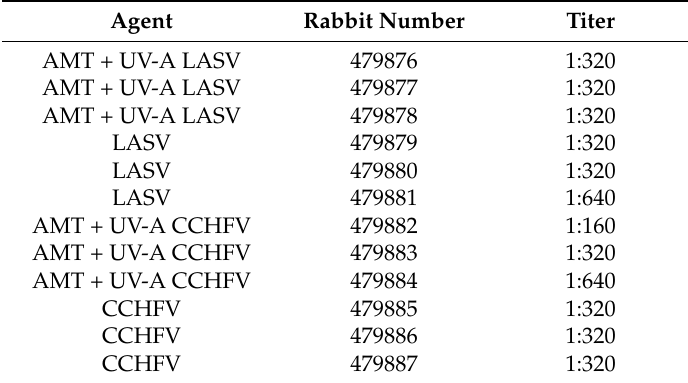
Table 6. Antibodies produced in response to live and 4 1 -aminomethyl-trioxsalen (AMT) + UV-A inactivated Lassa virus and Crimean-Congo hemorrhagic fever virus recognized untreated viruses of the same type equally